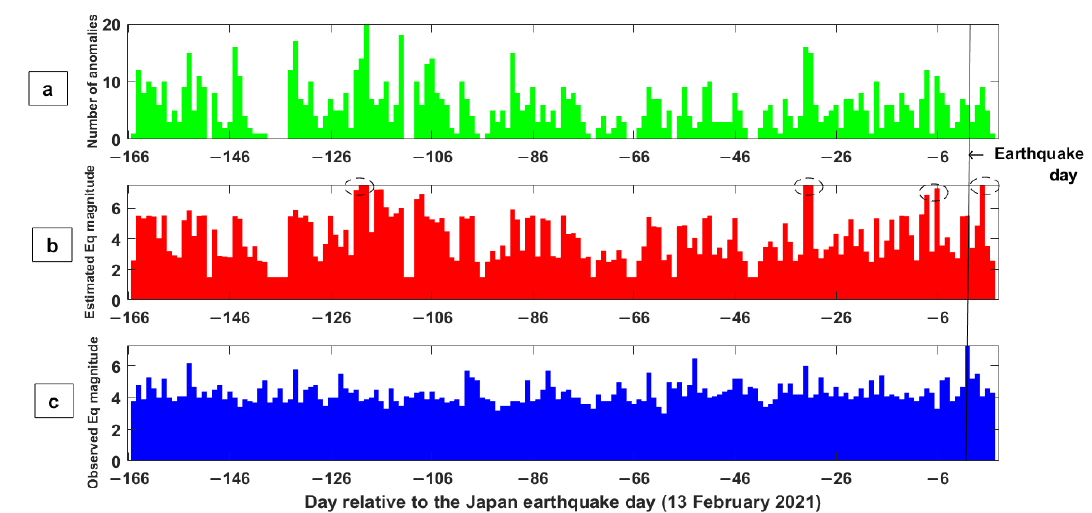
Figure 9. ( a ) Variation in the number of anomalies (green curve), ( b ) variation in the predicted earth- quake magnitude (red curve), and ( c ) variation in the observed earthquake magnitude (blue curve) for the Japan earthquake (13 February 2021) from 1 September 2020 to 18 February 2021. In both panels, the x -axis represents the day relative to the earthquake day, indicated as a vertical dotted line.